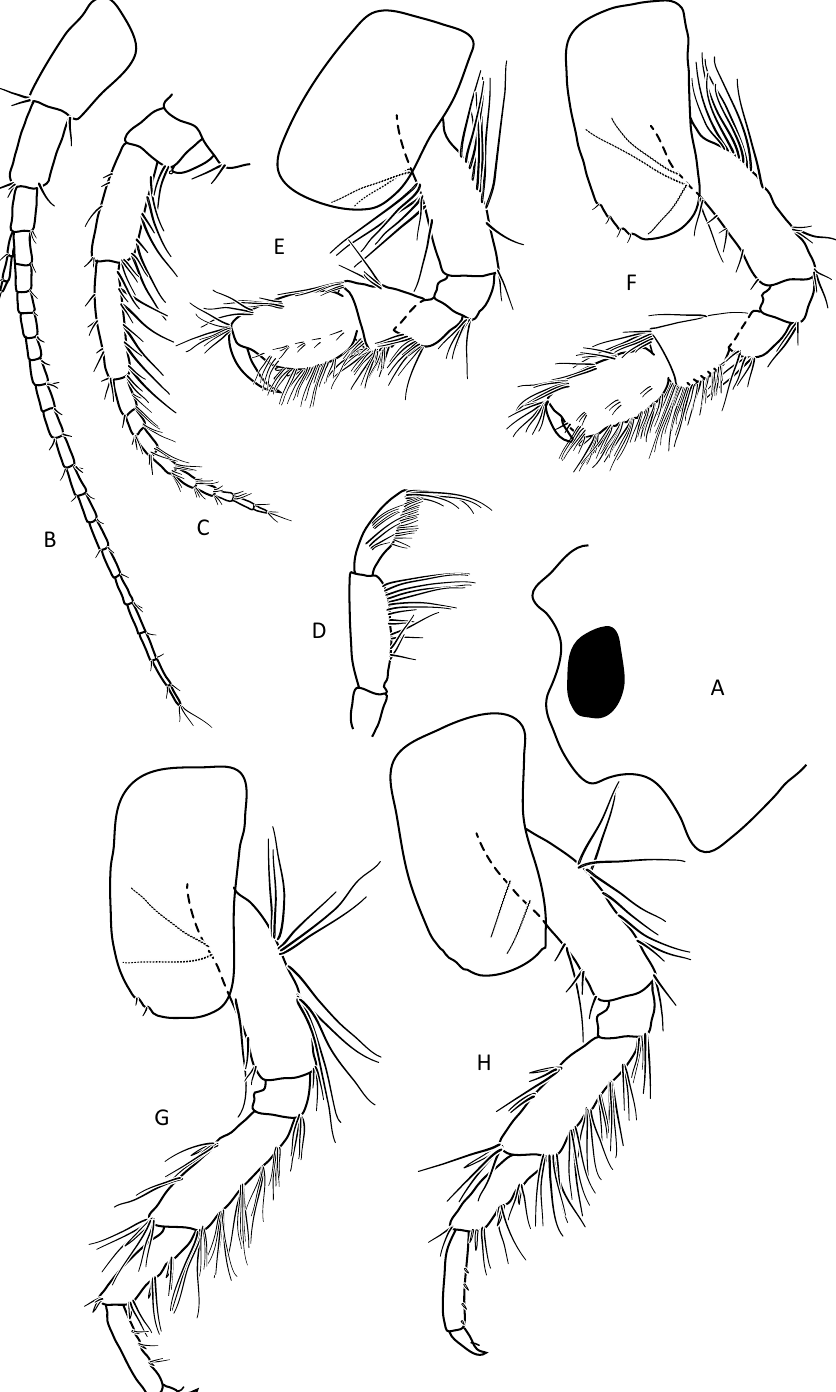
Figure 8. Gammarus stasiuki sp. nov., female—10 mm. ( a ) left side of head, ( b ) antenna 1, ( c ) antenna 2, ( d ) mandibular palp, ( e ) gnathopod 1, ( f ) gnathopod 2, ( g ) pereopod 3, ( h ) pereopod